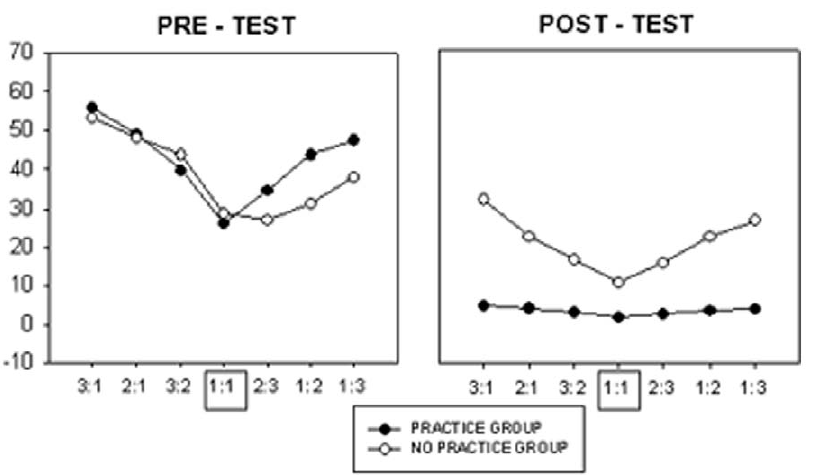
Figure 3. Three-factor interaction of finish offset error for Day, Group, and Frequency Ratio. The 1:1 pattern resulted in the smallest error and the non 1:1 ratios resulted in greater error. The pattern has the shape of a ‘seagull’. Frequency Ratios where the left hand rotates faster are represented by the left wing and Frequency Ratios where the right hand moves faster are represented by the right wing. After 4 days of practice, all coordination constraints are overcome, as indicated by the straight line.